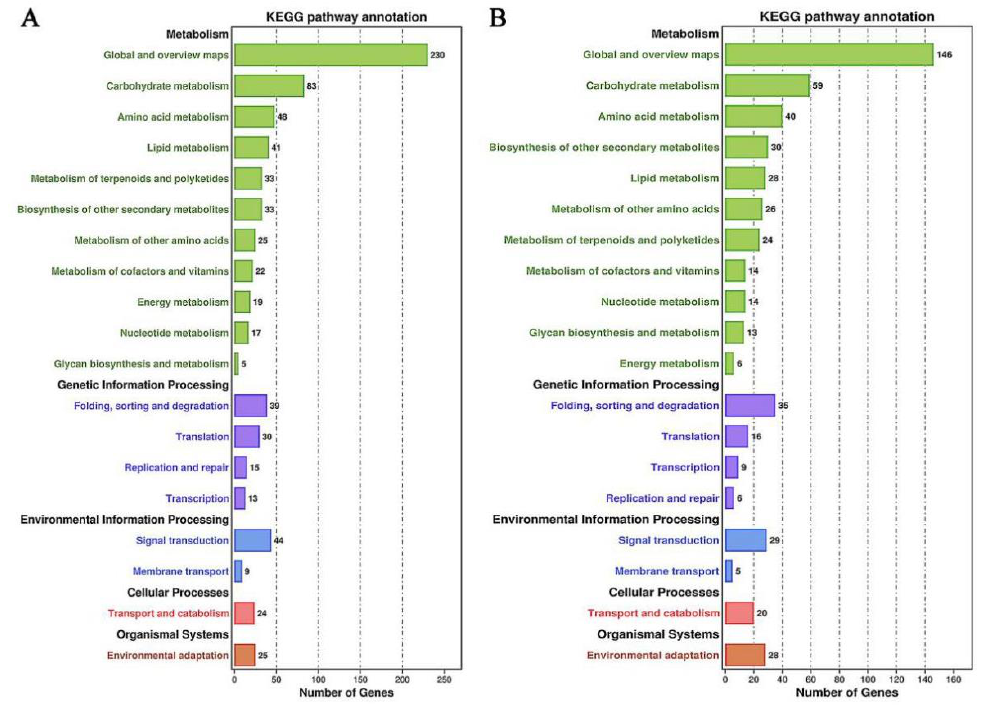
Figure 8. KEGG pathway analysis of transcriptome. The statistics of the number of DEGs in different metabolic pathways were obtained by KEGG enrichment analysis in sweetpotato for ( A ) 90 d and ( B ) 130 d, respectively. The number marked on the column was the number of DEGs enriched in this metabolic pathway.